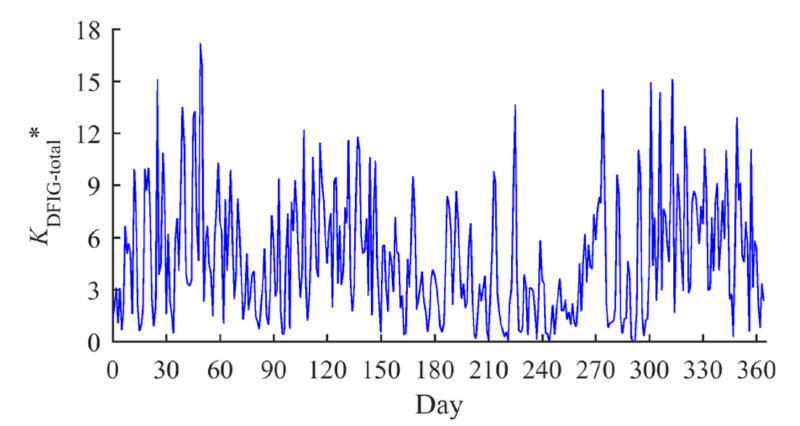
Figure 16. Aggregated K DFIG * of all wind farms in Shandong Province for a year, fluctuated significantly with the changing wind